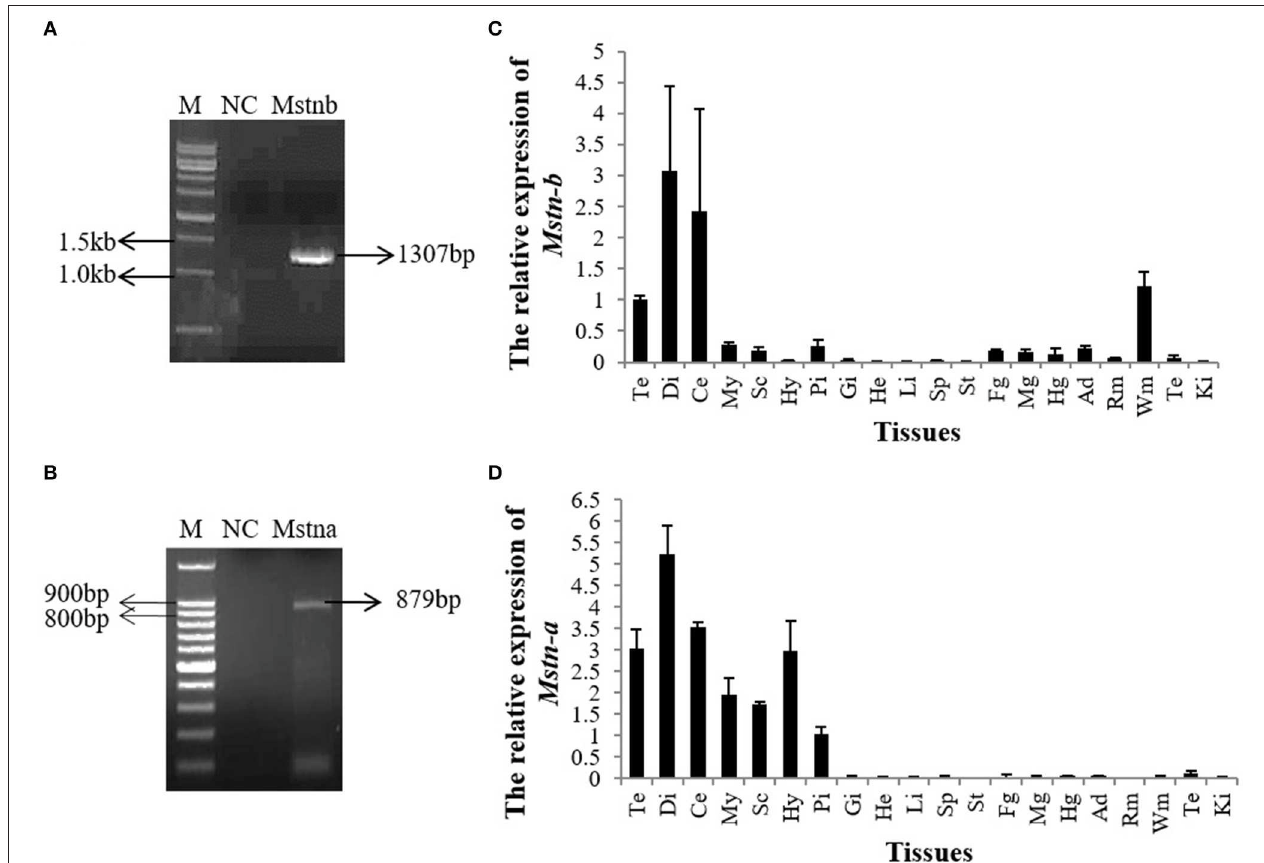
FIGURE 1 | The expression pattern of tilapia mstnb and mstna by qPCR. Mstnb and mstna clones were identified by PCR in (A) tilapia brain and (B) white muscle. Relative mRNA expression of (C) mstnb and (D) mstna in the tissues of tilapia ( n = 3, males). Te, telencephalon; Di, diencephalon; Ce, cerebellum; My, Myelencephalon; Sc, spinal cord; Hy, Hypothalamus; Pi, pituitary; Gi, gill; He, Heart; Li, Liver; Sp, spleen; St, stomach; Fg, foregut; Mg, midgut; Hg, hindgut; Ad, adipose tissue; Rm, red muscle; Wm, white muscle; Te, testis; Ki, Kidney. Bar: mean ± SEM.